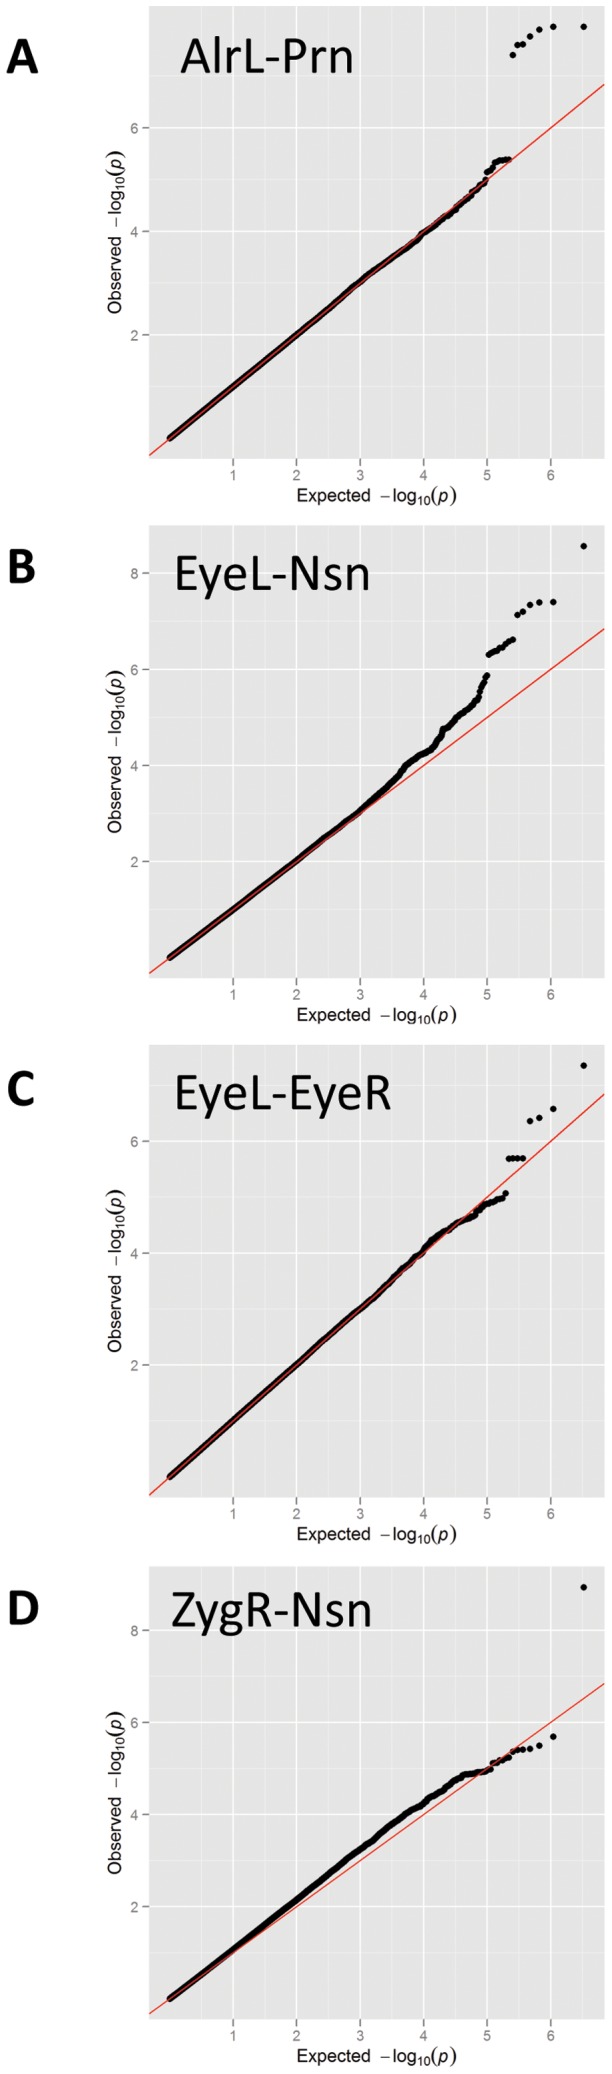
Quantile-Quantile (Q-Q) plots for the GWAS.Quantile-Quantile plots for the GWAS of (A) AlrL-Prn, (B) EyeL-Nsn, (C) EyeL-EyeR, and (D) ZygR-Nsn.